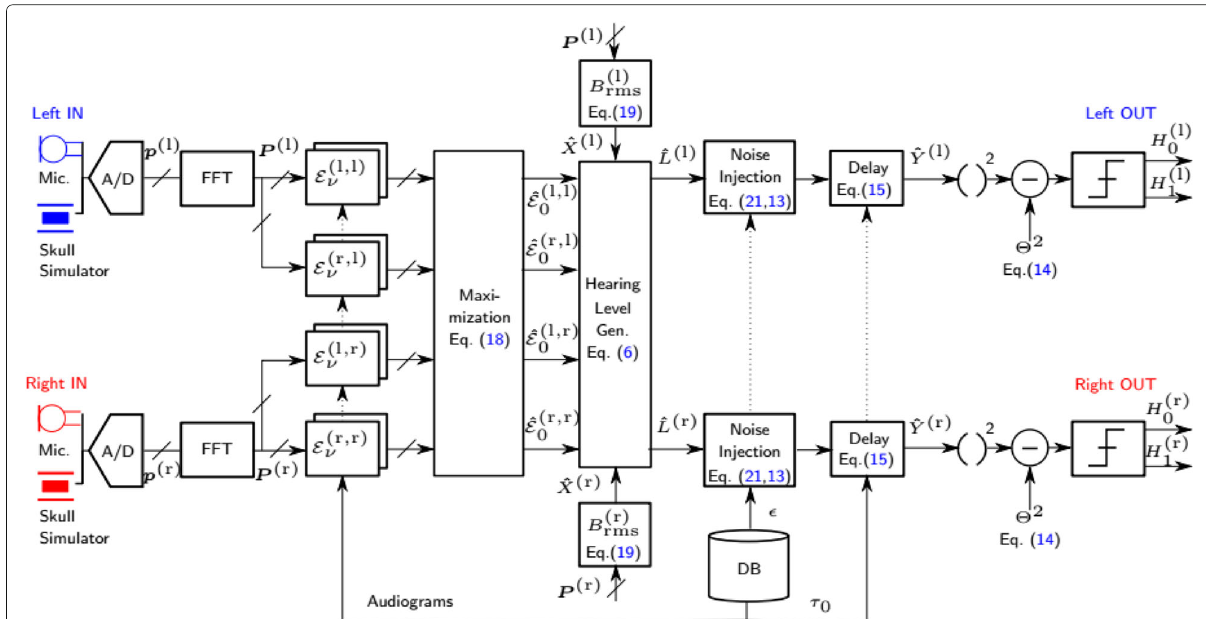
Fig. 2 Block diagram of the proposed artificial